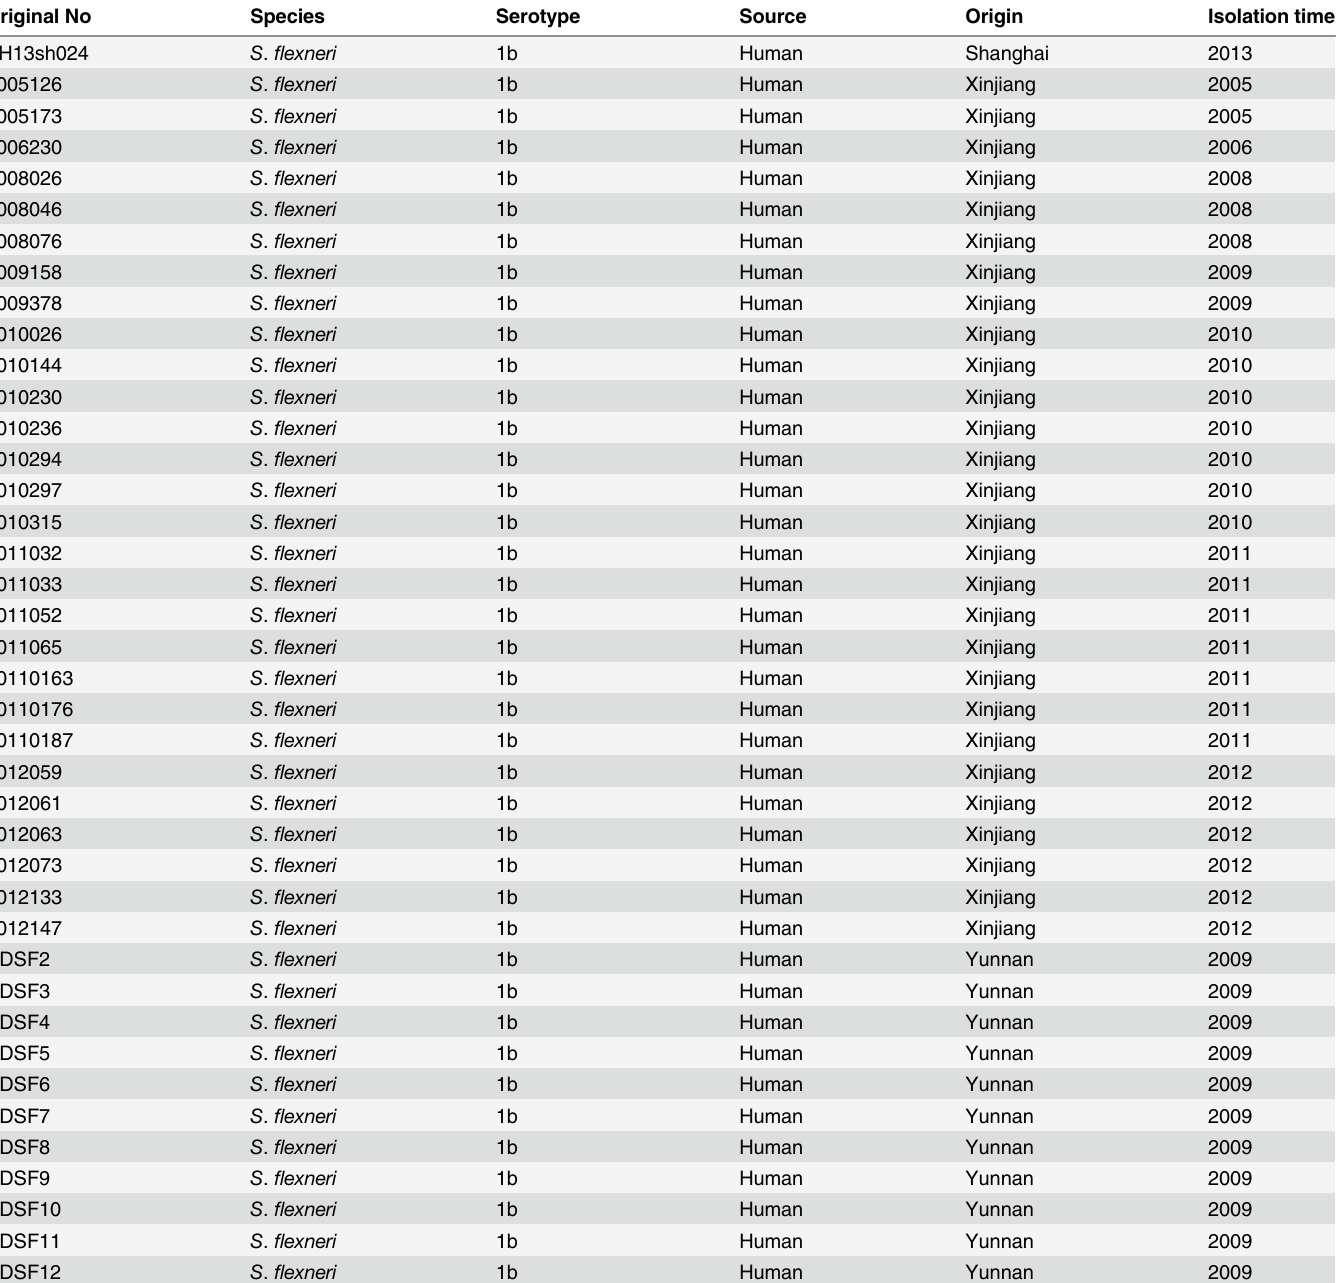
Table 2. Strain information of S . flexneri serotype 1b isolates from diarrheal patients. Original